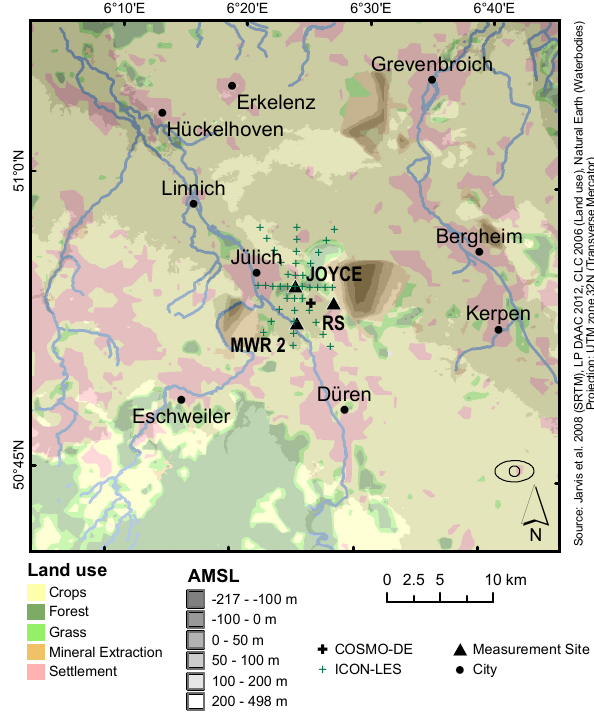
Figure 1. Map of measurement area. The measurement sites of GPS, MWR, sun photometer, BASIL (all JOYCE), radiosondes (RS), and the MWR only used in Sect. 3 (MWR 2) are marked with a black triangle. The ellipses in the lower right corner illus- trate the maximum and minimum size of MODIS footprints. Black and green crosses indicate COSMO-DE and ICON grid points used in Sect.